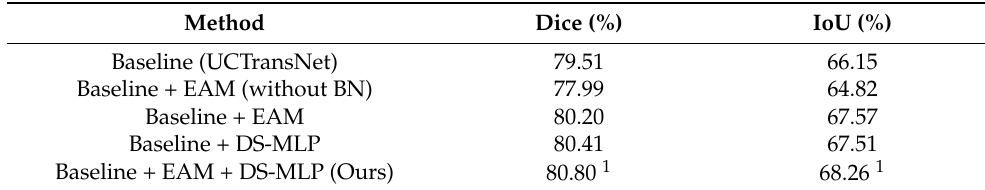
Table 4. Ablation experiments on MoNuSeg datasets. The superscript “1” indicates the best experi- mental